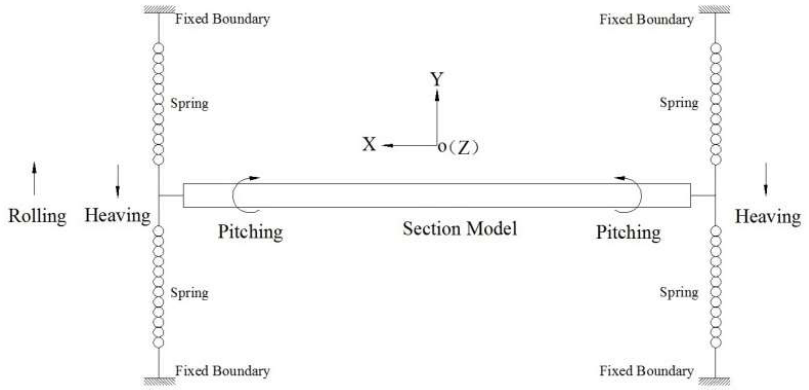
Figure 4. Possible degrees of freedom (DOFs) of the section model.